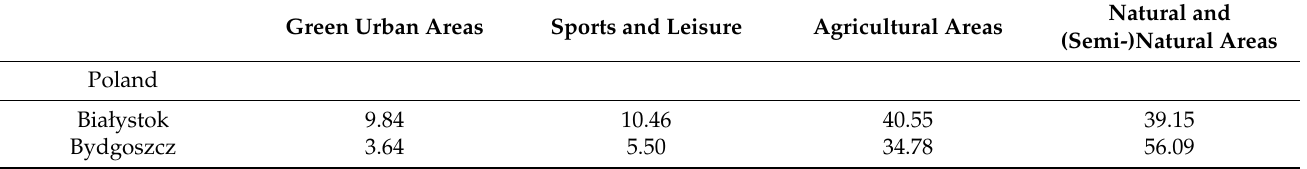
Table 2. Distribution of the GI across the different categories (14,100—green urban areas, 14,200—sports and leisure, 20,000—agricultural areas, and 30,000—natural and (semi-)natural areas) in Romanian and Polish cities covered by Urban Atlas data. The values represent the share of the area of each category from the total GI area per